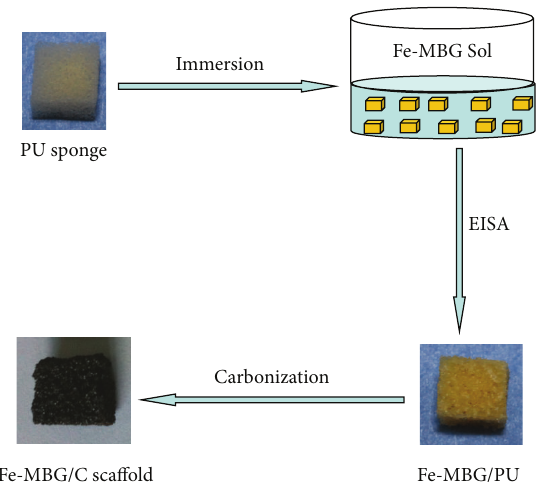
Figure 1: The schematic procedure for the preparation of the Fe- MBG/C composite